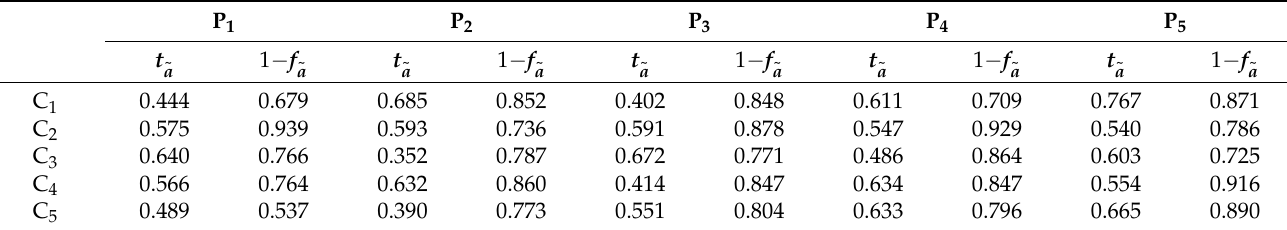
Table 19. Collective Vague Fuzzy Decision Matrix.